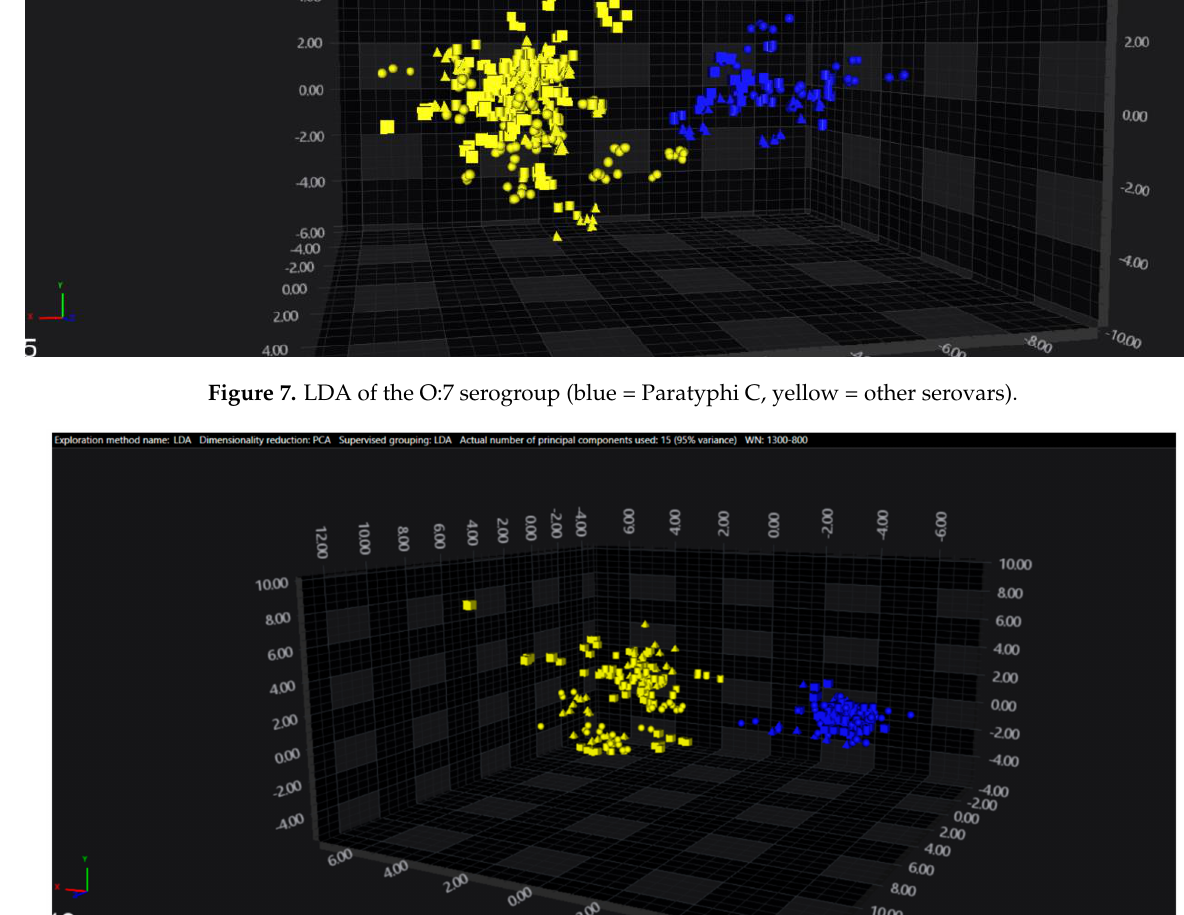
Figure 8. LDA of the O:9 serogroup (blue = Typhi, yellow = other